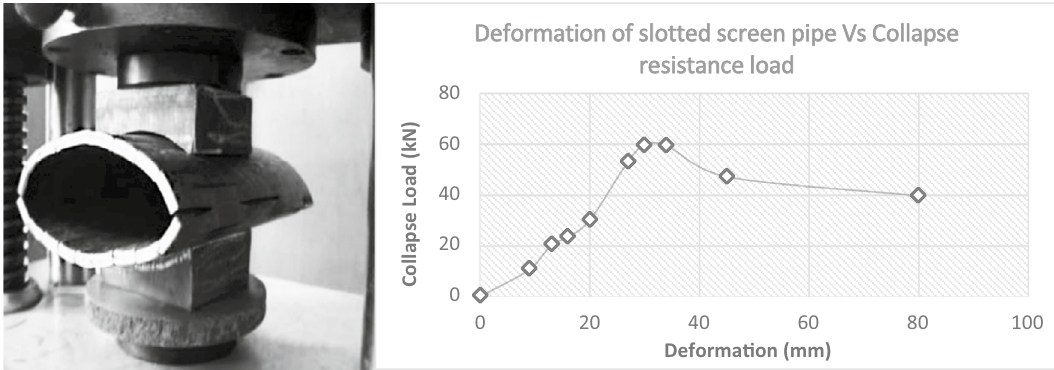
Fig. 6 Collapse resistance load of slotted screen